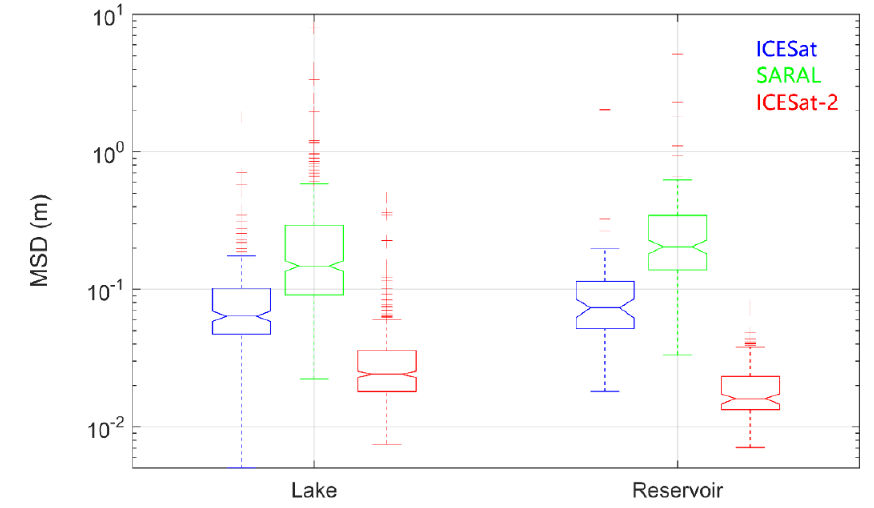
Figure 7. Comparison between lakes and reservoirs in MSD for different satellites. For the ICESat, SARAL, and ICESat-2, the distribution of MSD of lakes or reservoirs are shown in blue, green, and red boxes, respectively.